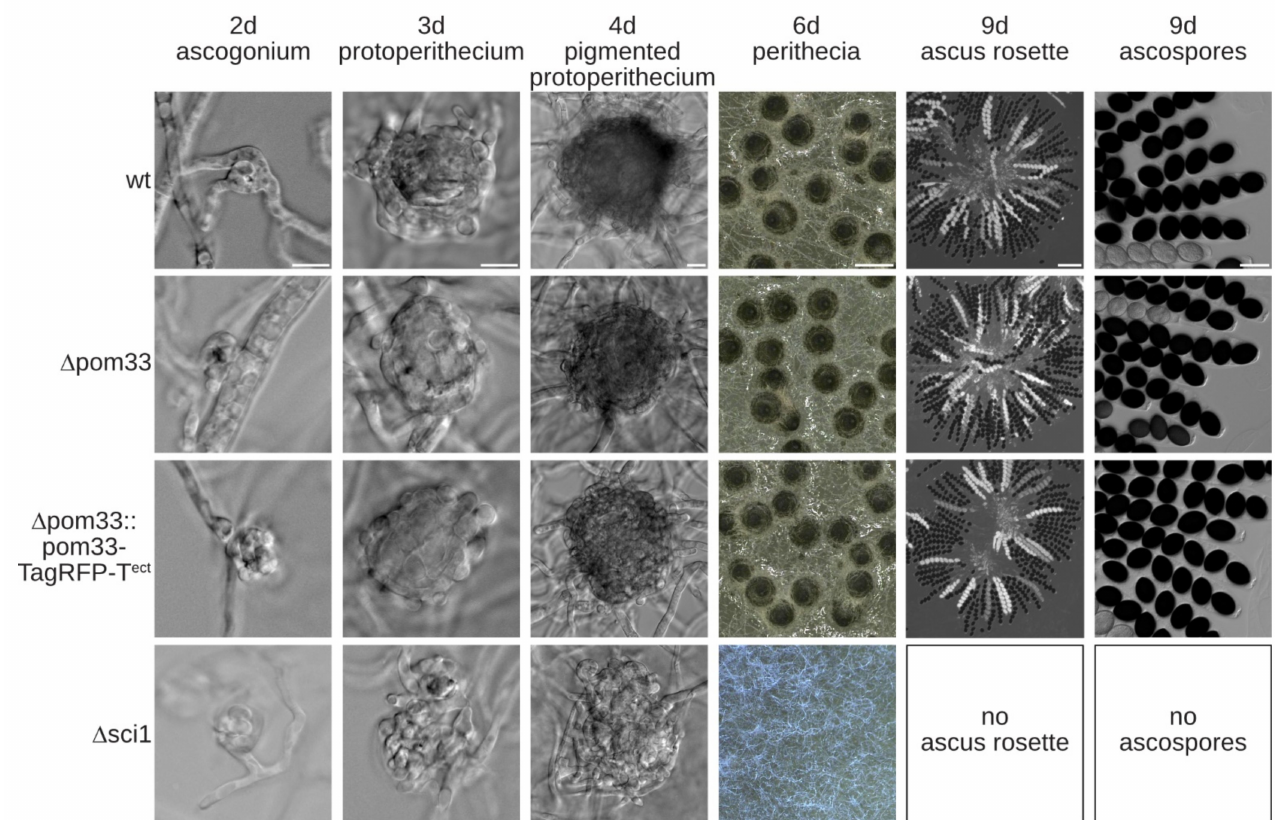
Figure 3. Sexual development in the wt, ∆ pom33, the complementation strain and ∆ sci1. Microscopic investigation of wt, ∆ pom33, the complementation strain ( ∆ pom33::pom33-TagRFP-T ect ) and ∆ sci1 grown over cellophane on SWG agar plates at 27 ◦ C. Photographs were taken at indicated days. Scale bars from left to right: 10 µ m; 10 µ m; 10 µ m; 0.5 mm; 100 µ m and 25 µ